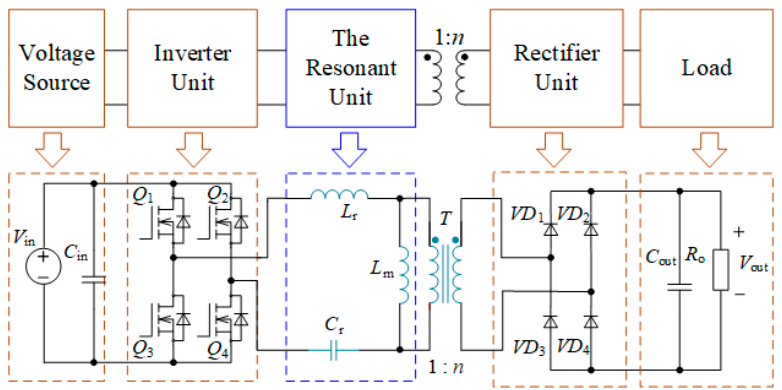
Figure 2. The topology of the LLC resonant